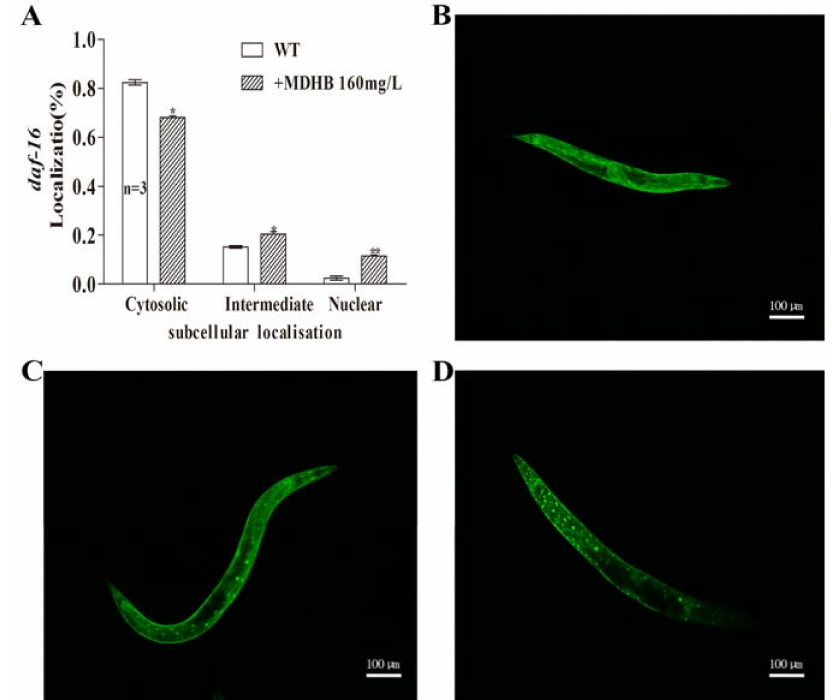
Figure 7. MDHB induced nuclear localization of daf-16 . ( A ) Data from different group exposure to 160 mg/L MDHB or not are described as means ± S.E.M to show the percentile of animals displaying cytosolic, intermediate or nuclear of localization. Statistical significance among animals of the control groups and MDHB groups was analyzed by one-way ANOVA followed by Bonferroni (post-hoc) correction (* p < 0.05, ** p < 0.01). ( B – D ) Micrographs elucidate typical daf-16 localization in TJ356 transgenic strains. ( B ) daf-16 mainly locating in the cytoplasm, ( C ) mainly locating in cytoplasm and nucleus, ( D ) mainly in the nucleus. This experiment was repeated